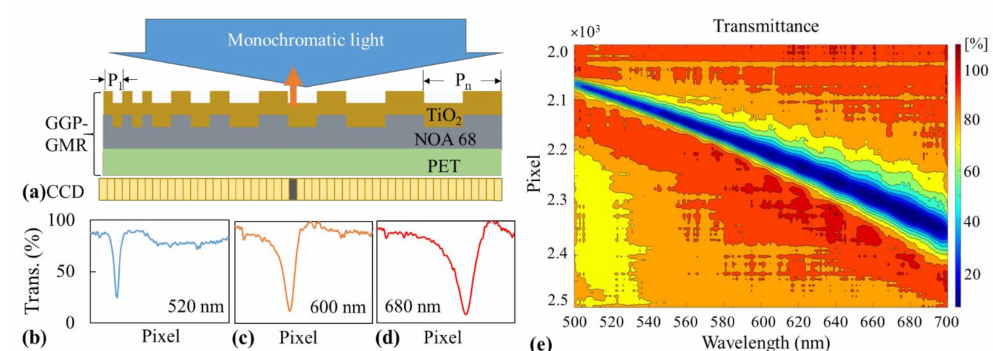
Figure 1. ( a ) Illustration of a three-layer gradient grating period guided-mode resonance (GGP-GMR) device on top of a charge-coupled device (CCD). The large blue arrow indicates an incident light with a specific wavelength, and the orange arrow indicates the light reflected at a specific grating period. The reflected light indicated by the orange arrow results in the minimum intensity in the underneath CCD pixel (represented in dark gray). Intensity distribution on the CCD for incident wavelengths of ( b ) 520, ( c ) 600, and ( d ) 680 nm. ( e ) Calibration diagram of the transmission efficiency at each pixel for each